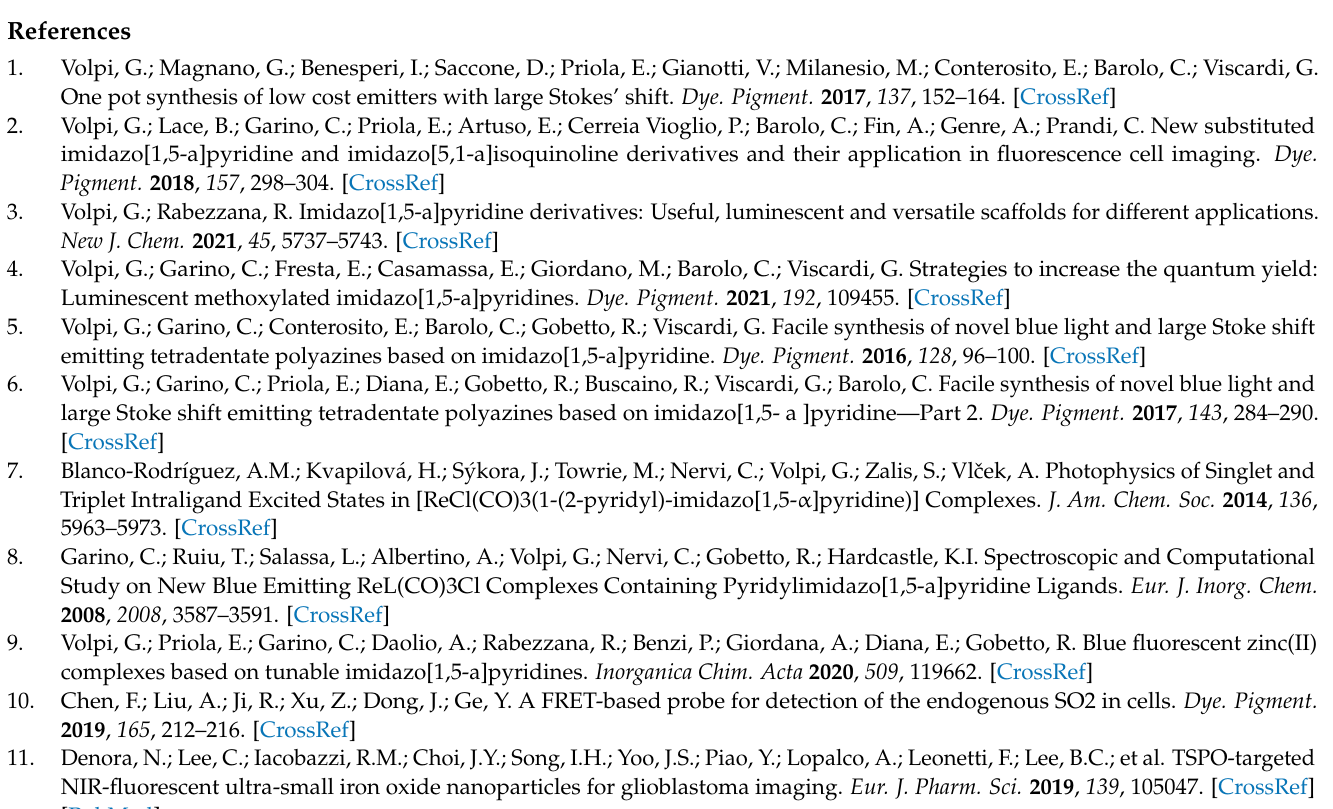
Figure S12: the 1 H NMR spectrum of Methanol-d 4 solution of 2q, Figure S13: the 1 H NMR spectrum of Chloroform-d 3 solution of 3, Figure S14: the 2D 1 H COSY-NMR spectrum of Chloroform-d 3 solution of 3, Figure S15: the 13 C NMR spectrum of Chloroform-d 3 solution of 3, Figure S16: the 1 H NMR spectrum of Methanol-d 4 solution of 3q, Figure S17: experimental and calculated absorption spectra of 2, Figure S18: experimental and calculated absorption spectra of 2q, Figure S19: experimental and calculated absorption spectra of 3, Figure S20: experimental and calculated absorption spectra of 3q, Figure S21: molecular orbital plots (LUMO and HOMO) of the reported compounds, Figure S22: absorption and emission spectra of 1 recorded in DCM solution (concentration 10 − 5 M) and in thin film, Figure S23: emission spectra of 1 recorded in different conditions: DCM solution, thin film, and blended in PMMA and in PS, Figure S24: absorption and emission spectra of 1q recorded in DCM solution (concentration 10 − 5 M), in thin film and blended in PS matrix, Figure S25: absorption and emission spectra of 2 recorded in DCM solution (concentration 10 − 5 M), in thin film and blended in PS matrix, Figure S26: absorption and emission spectra of 3 recorded in DCM solution (concentration 10 − 5 M), in thin film and blended in PS